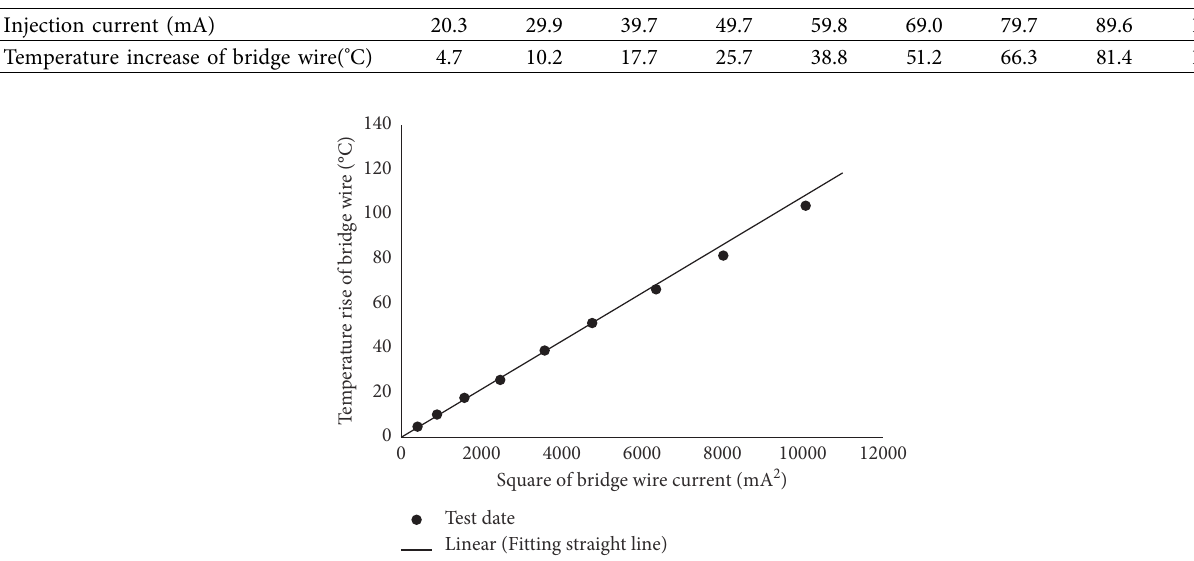
Figure 5: Relationship between temperature increase of the bridge wire and square of injection current.